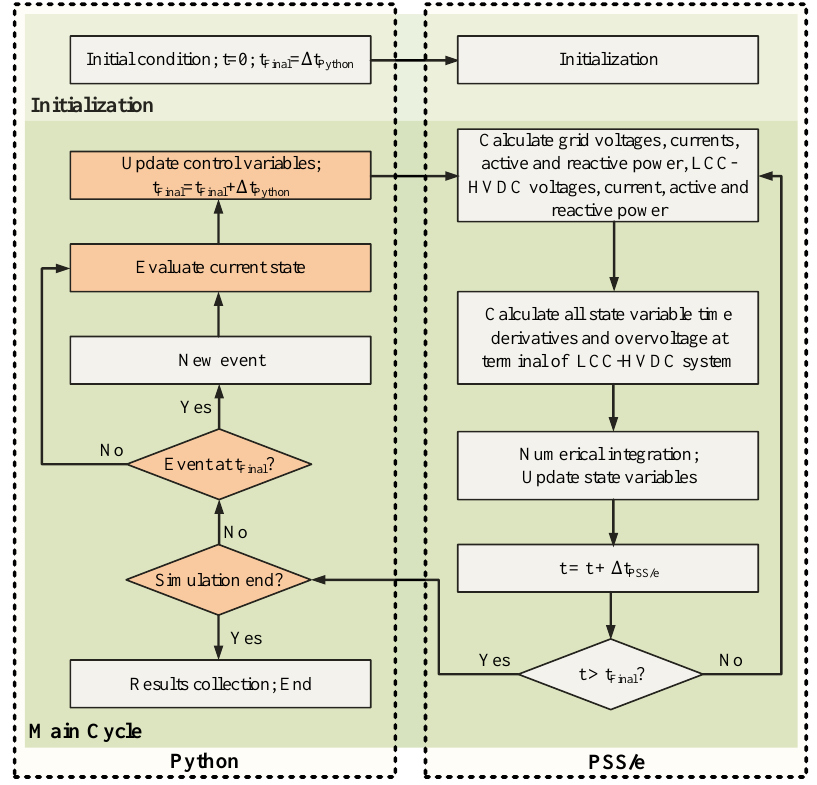
Figure 4. Iterative study method through Python-based API with PSS/e [62]. “Rights: